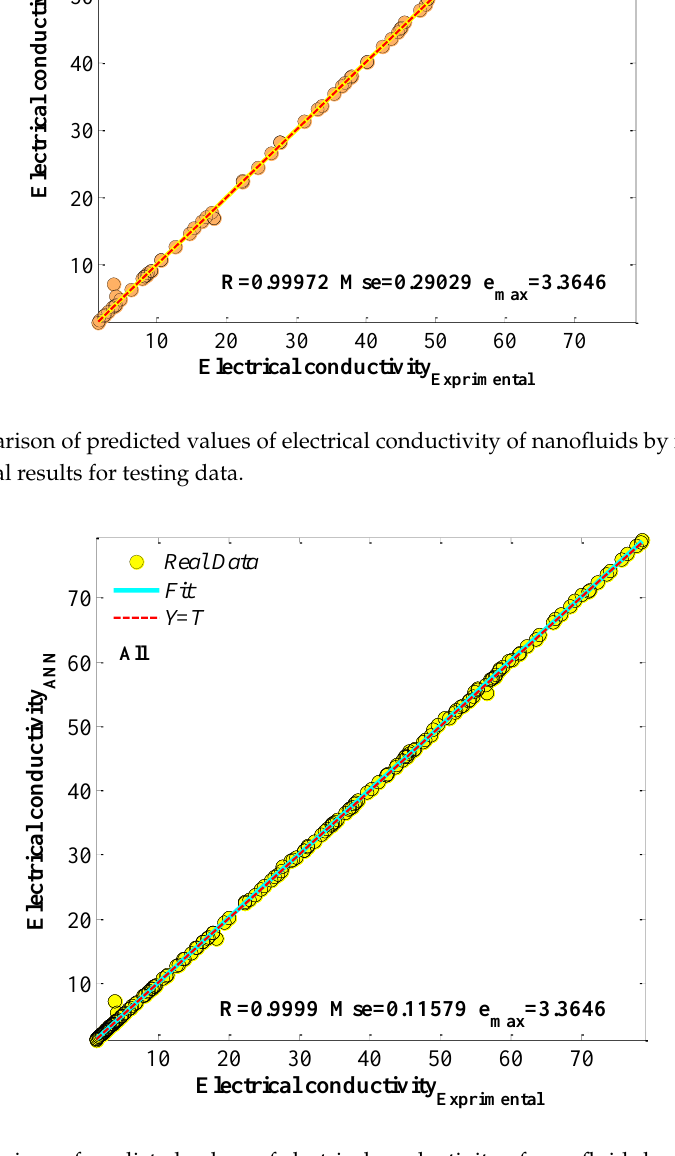
Figure 9. Comparison of predicted values of electrical conductivity of nanofluids by neural networks and experimental results for all data .